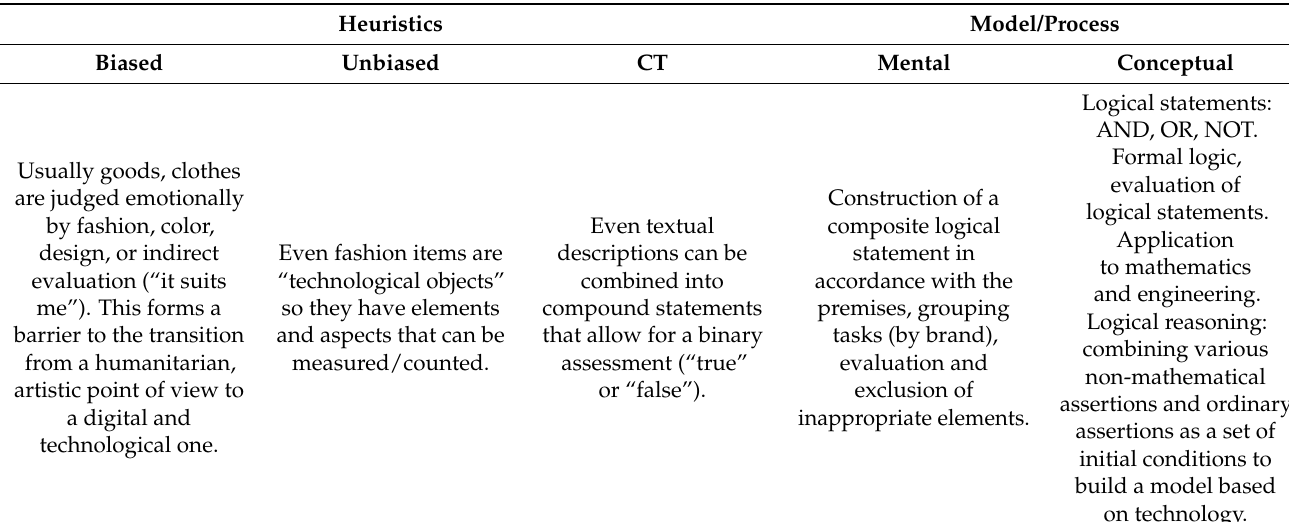
Figure 5. A sample of the Bebras short task on logics for primary level (age 8–10). Retrieved by permission from www.bebras.org (accessed on 24 February 2022). Table 1. A case of the Bebras short task on logics aimed at scaffolding CT mindset (elaborated by the authors).